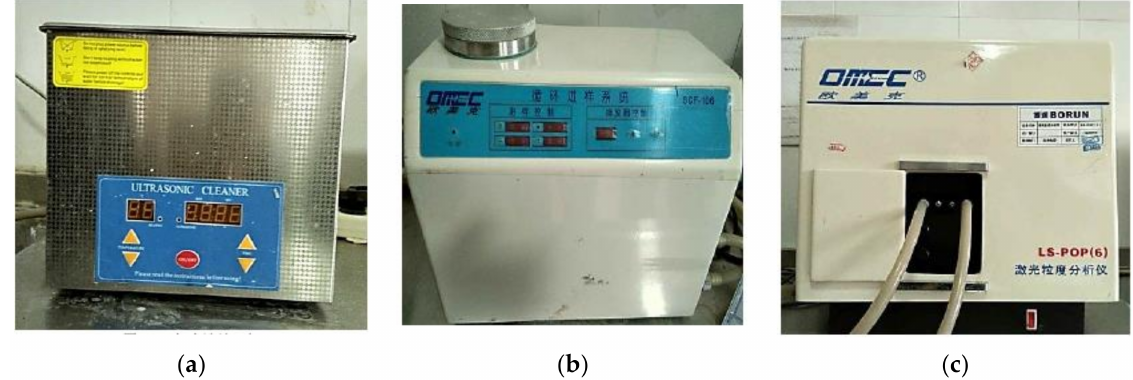
Figure 3. Laser particle analyzer (LS-POP6). ( a ) Ultrasonic washing unit; ( b ) sample loading unit; ( c ) testing